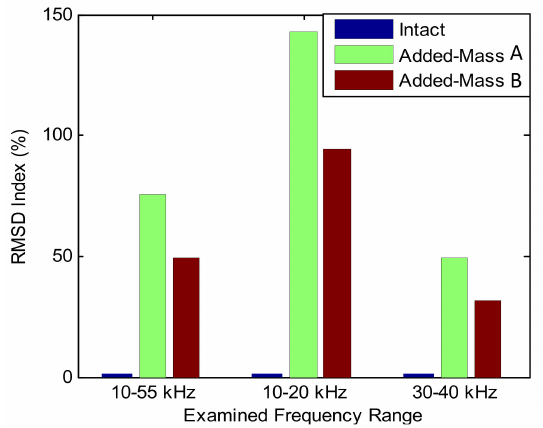
Figure 20. Numerical impedance features (RMSD indices) of PZT interface under damage cases in connection splice